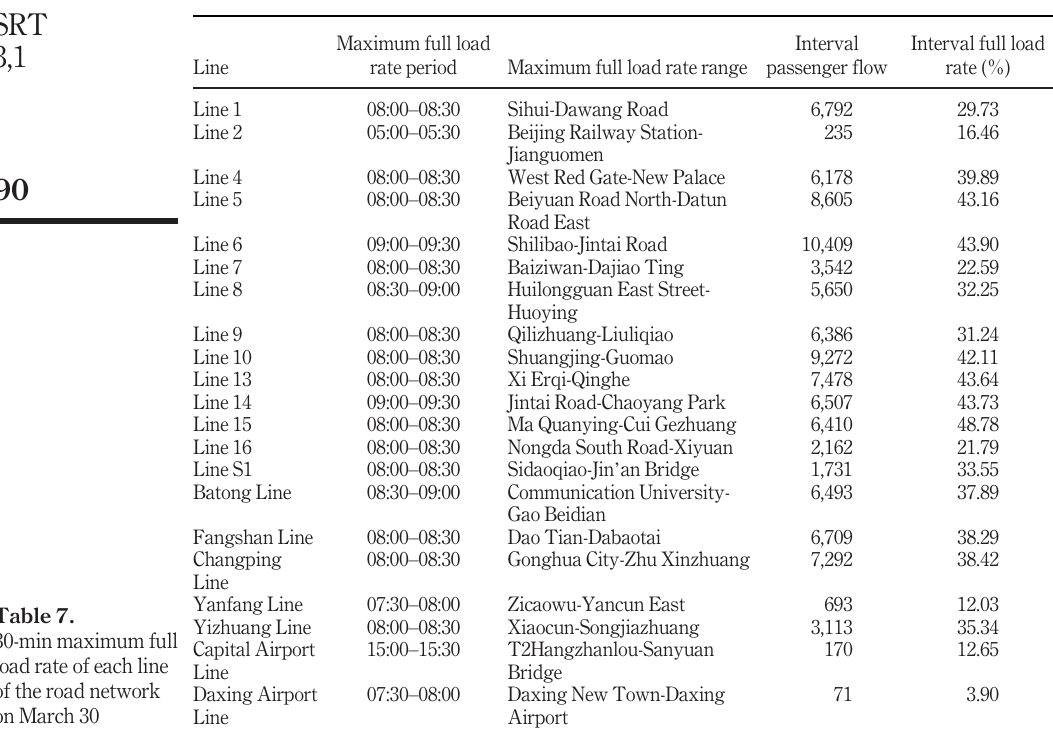
Table 7. 30-min maximum full load rate of each line of the road network